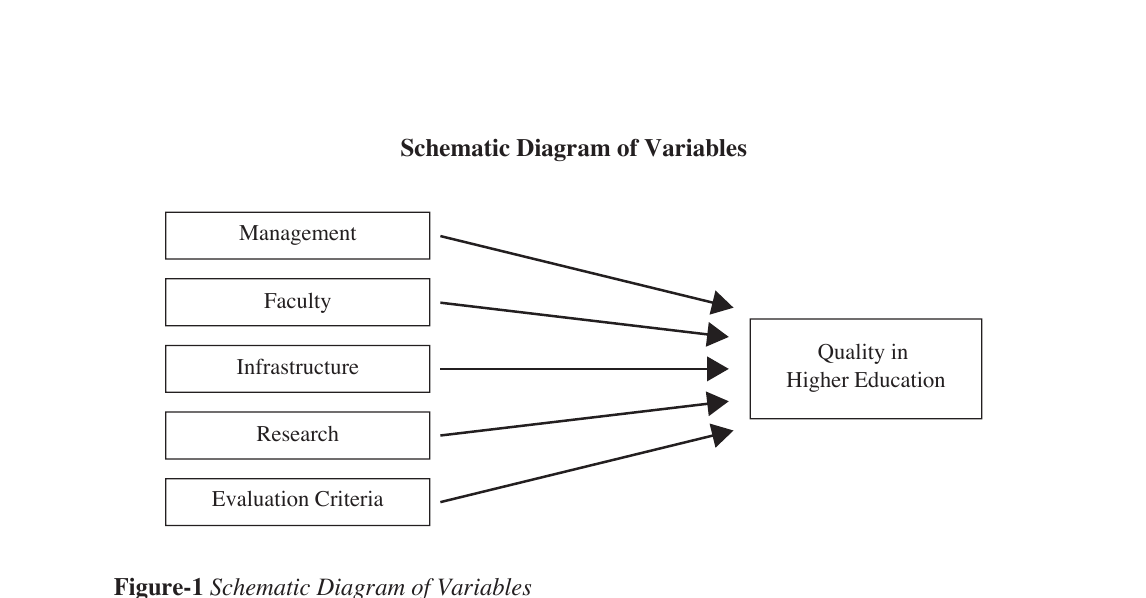
Figure-1 Schematic Diagram of